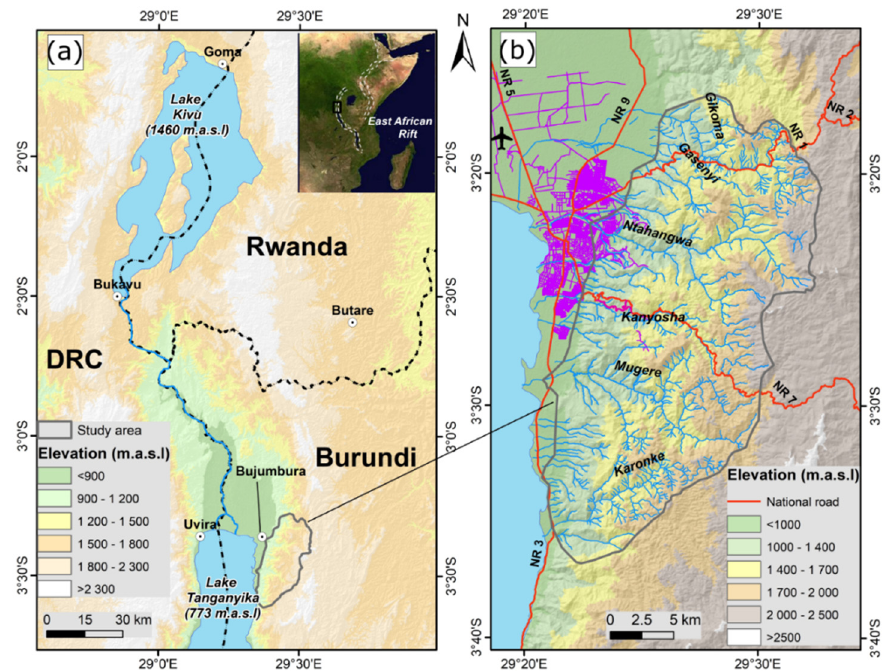
Figure 1. Location of the study area. ( a ) Central portion of the western branch of the East African Rift; ( b ) populated hillslopes of the city of Bujumbura with the drainage network of the main watersheds (delineated with the grey line). The hillshade is derived from 1 Arc-Second SRTM data [47]. The road network in violet and the national roads (NR) in red are from OpenStreetMap.